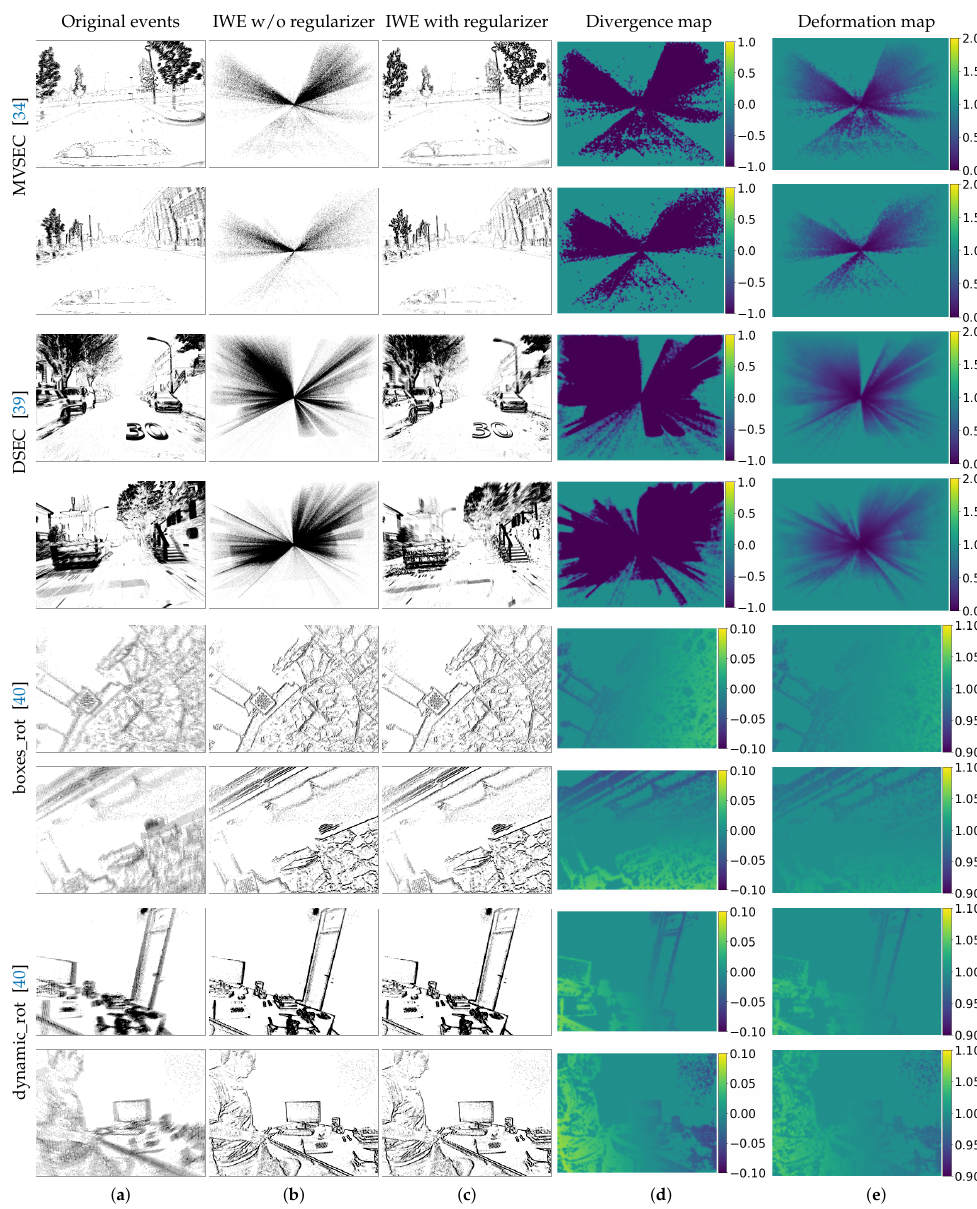
Figure 6. Proposed regularizers and collapse analysis . The scene motion is approximated by 1-DOF warp (zoom in/out) for MVSEC [34] and DSEC [39] sequences, and 3-DOF warp (rotation) for boxes and dynamic ECD sequences [40]. ( a ) Original events. ( b ) Best warp without regularization. Event collapse happens for 1-DOF warp. ( c ) Best warp with regularization. ( d ) Divergence map ((10) is zero-based). ( e ) Deformation map ((15), centered at 1). Our regularizers successfully penalize event collapse and do not damage non-collapsing